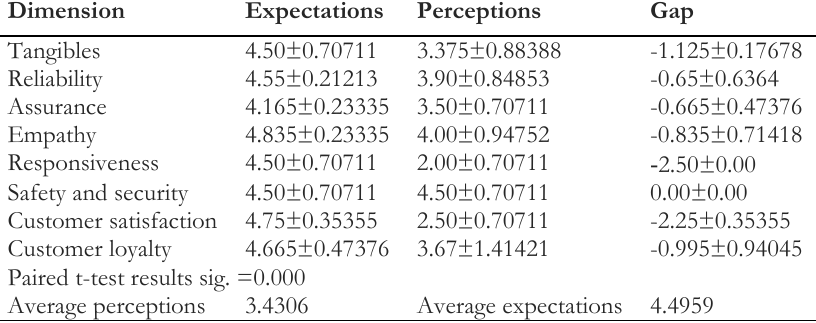
Table 9. Gap quality analysis of reverse support services-unit 6.